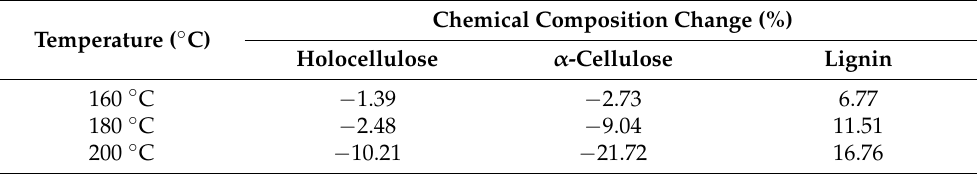
Table 2. Relative content change rates of bamboo chemical compositions after heat treatment. Chemical Composition Change Temperature ( ◦ C)